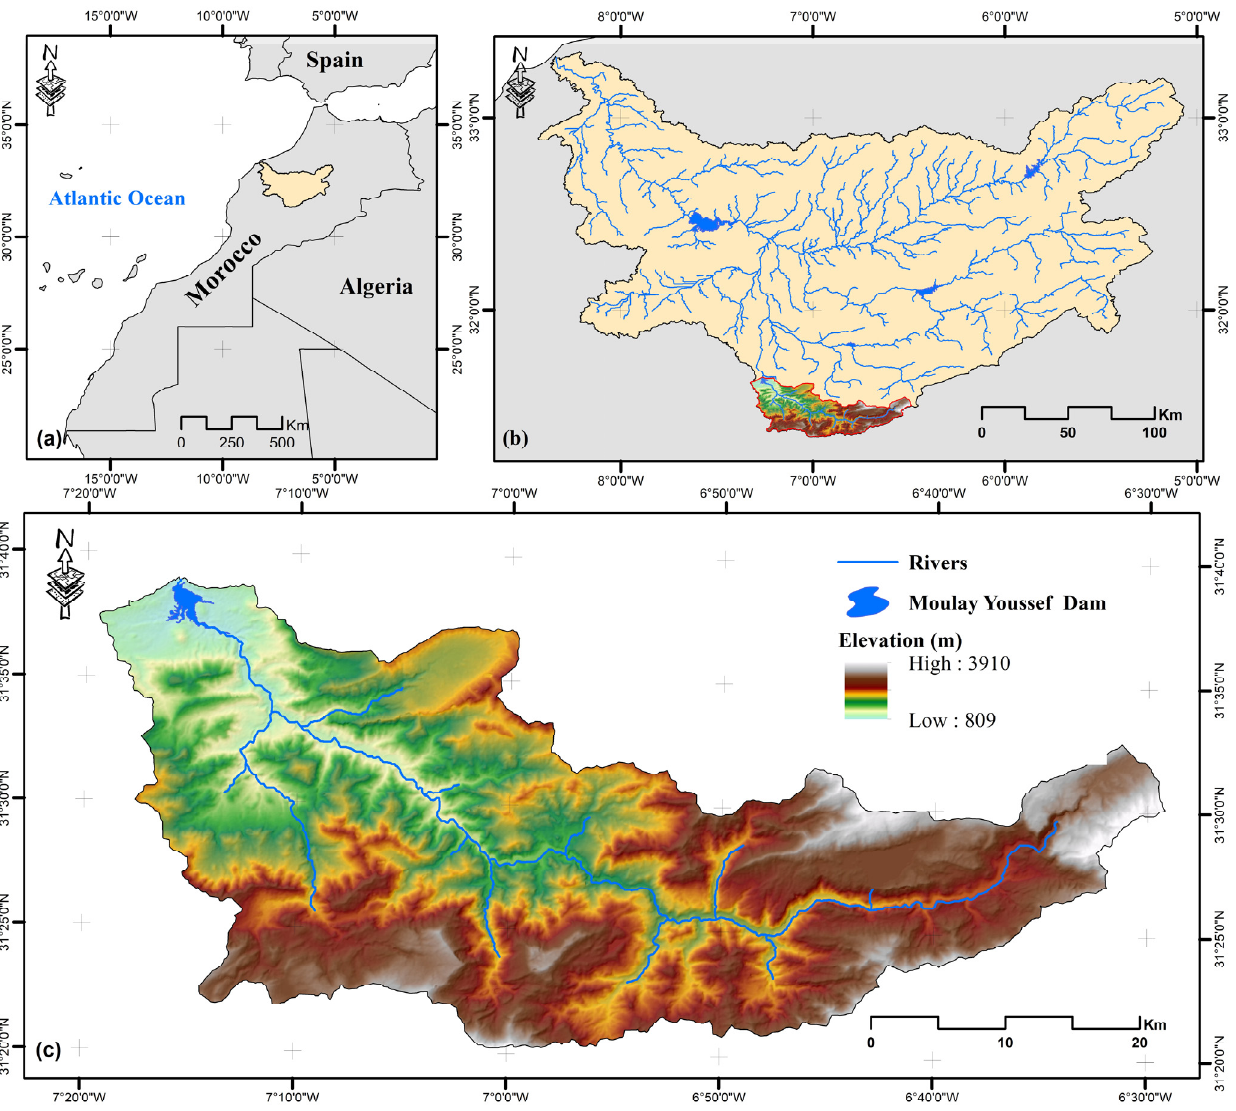
Figure 1. The geographical location of the research region; ( a ) on Moroccan scale, ( b ) on Oum Er-Rbia watershed scale, and ( c ) digital elevation model of the Tassaoute catchment (upstream of the Moulay Youssef Dam). Table 1. Basic characteristics of Tassaoute